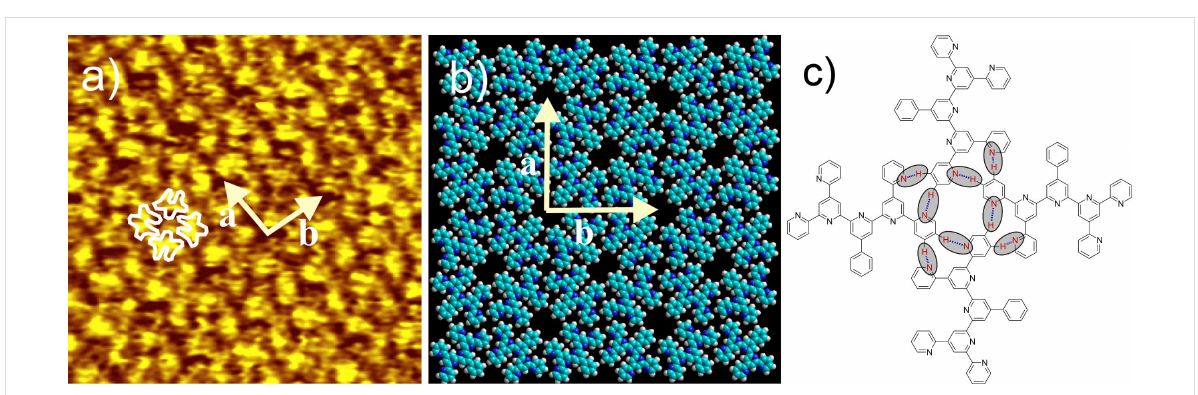
Figure 6: a) 15 × 15 nm 2 STM image ( I set = 3.41 nA, V set = − 660 mV) of 2,2'-PhSpPy ( 14 ) at the HOPG/TCB interface [ a = 3.0 ± 0.1 nm, b = 3.0 ± 0.1 nm, a,b = 92 ± 3°] with four overlaid molecules; b) model of the 2,2'-PhSpPy ( 14 ) square pattern; c) hydrogen bonding motif of 2,2'-PhSpPy ( 14 ); the hydrogen bonds are marked by ovals.